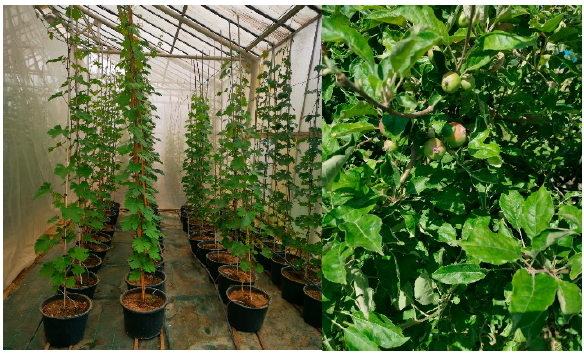
Figure 1. Aspect of treated cultures: left —greenhouse tests, right —field